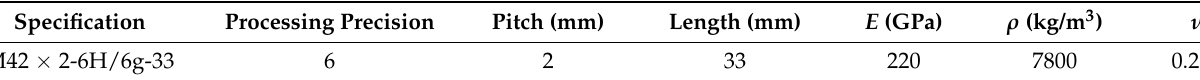
Table 8. Material parameters (source elaborated by authors).